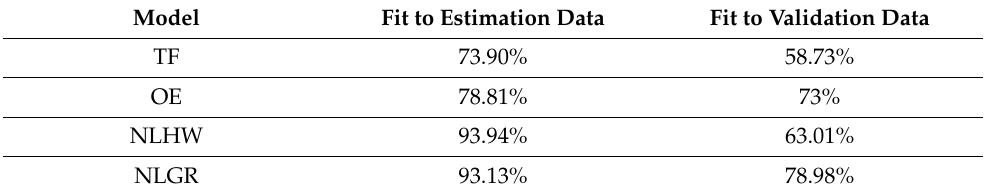
Table 5. Fit comparison between estimation data and validation data with TF, OE, NLHW, and NLGR.